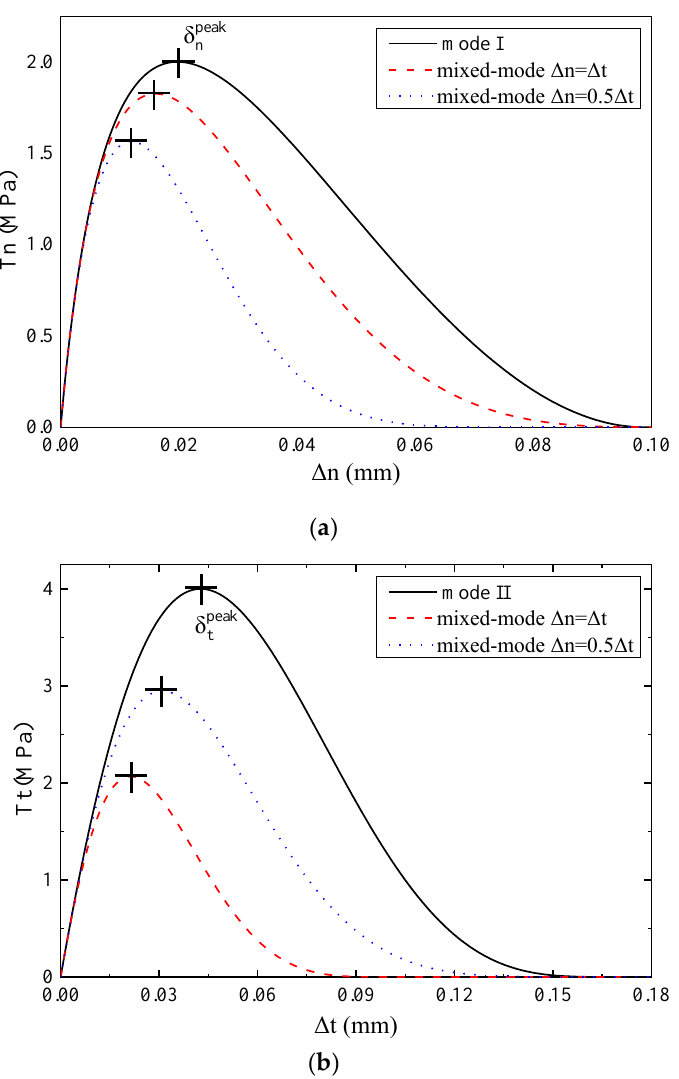
Figure 12. Variations of the normal traction component ( a ) and tangential component ( b ) under mode I (mode II) loading, mixed-mode Δ 𝑛 = Δ 𝑡 , and mixed-mode Δ 𝑛 = 0.5Δ 𝑡 .